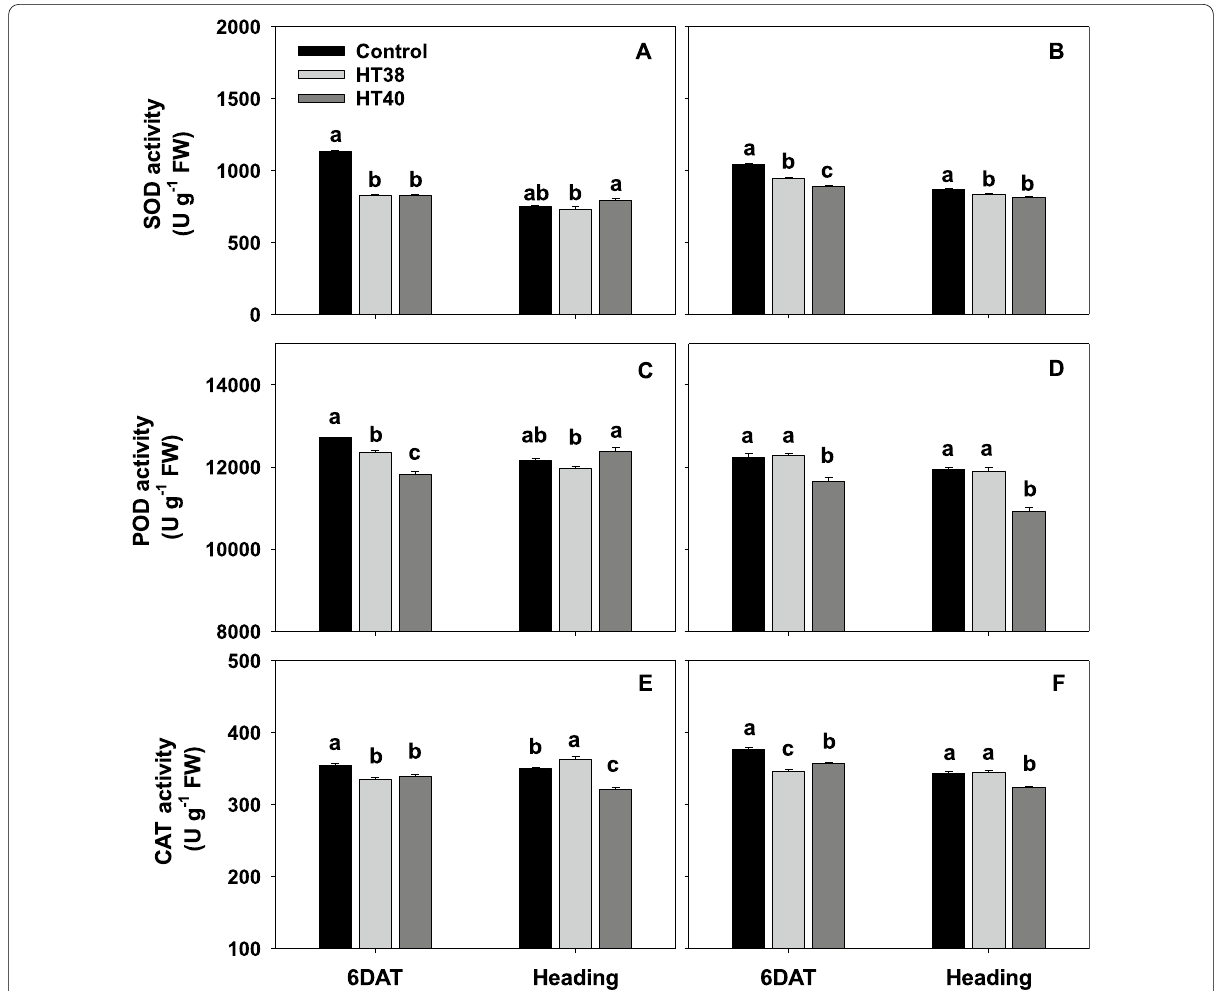
Fig. 7 Changes in antioxidant enzymatic activities in pistils of N22 ( A , C and E ) and IR64 ( B , D and F ) exposed to six days of control and heat stress (38 °C—HT38; 40 °C—HT40) treatments at gametogenesis and recovery at heading stage. Values shown are mean with common letter are not significantly different between temperature treatments in a genotype at P Peroxidase; CAT, Catalase. 6DAT ‑ six days after